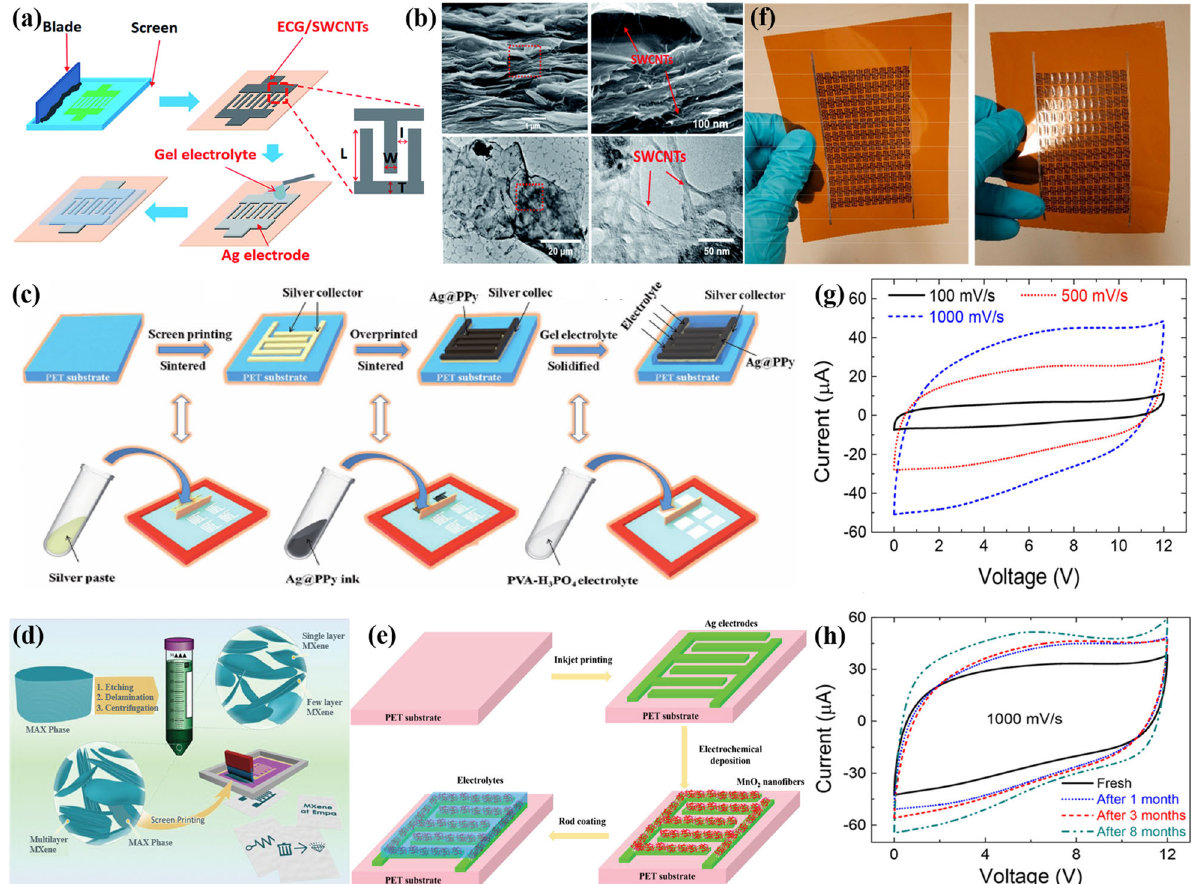
Fig. 2 Fabrication methods of screen printing and inkjet printing. a Schematic illustration for preparing the all screen-printable MSCs. b SEM images for the graphene/CNTs hybrid electrodes. c Fabrication process of the Ag@Ppy ink-based MSCs. d Schematic illustration of direct screen printing of MXene sediments. e Fabrication of the fl exible MSCs with MnO 2 porous nano fi ber-like electrodes. f Photos of large- scale integration of fully printed MSCs on Kapton. CV pro fi les of the MSC array at g different scan rates and h different periods. a , b Reproduced with permission 30 (Copyright © 2019, Royal Society of Chemistry). c Reproduced with permission 39 (Copyright © 2017, John Wiley and Sons). d Reproduced with permission 41 (Copyright © 2020, John Wiley and Sons). e Reproduced with permission 52 (Copyright © 2019, John Wiley and Sons). f – h Reproduced with permission 29 (Copyright © 2017, American Chemical